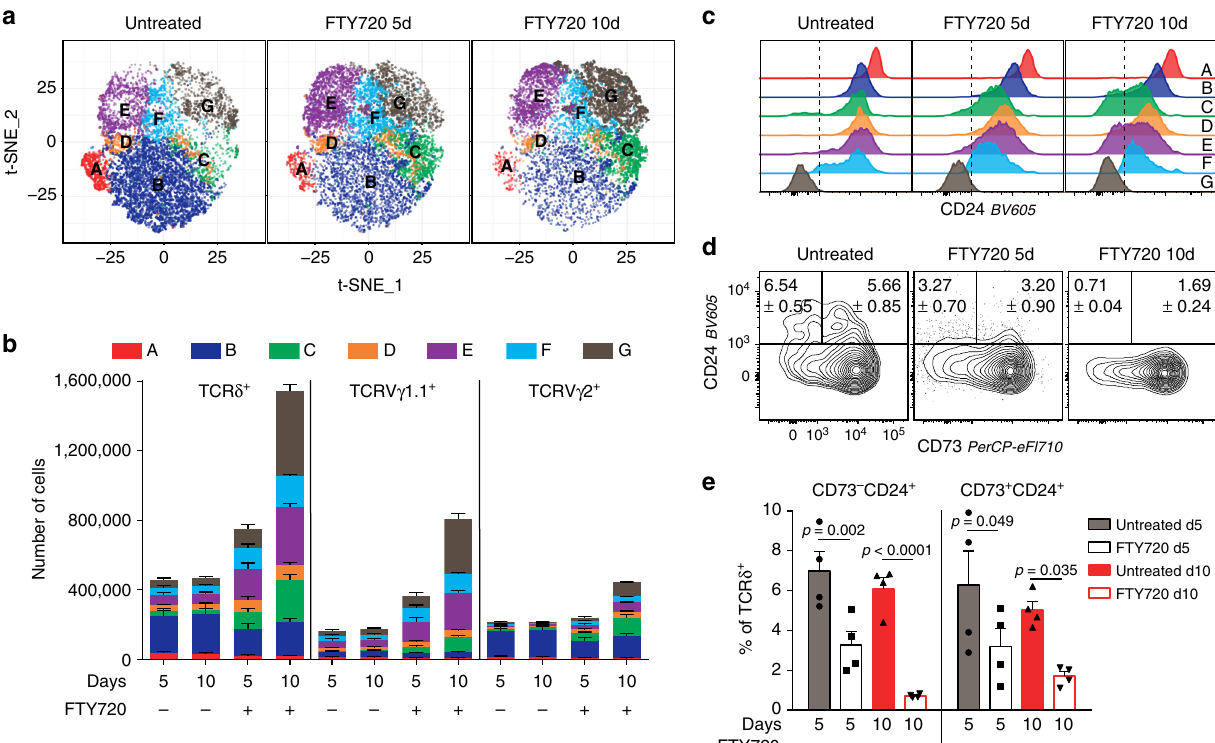
Fig. 5 γδ T cells emigrate from the thymus at the C, E and G stages a , b TCR δ + thymocyte distributions within population A to G after treatment with FTY720 for 5 (5d) or 10 days (10d) visualised using a t-SNE maps and b stacked bar plots of cell numbers within TCR δ + , V γ 1.1 + and V γ 2 + subsets. c Representative CD24 expression within A to G populations after treatment with FTY720 for 5 or 10 days. d , e Expression of CD24 within CD73 − and CD73 + TCR δ + cells from inguinal lymph nodes after FTY720 treatment for 5 and 10 days as d representative fl ow cytometry plots and e quantitative bar plots showing the percent of TCR δ + cells within each population. Data from two independent experiments for both 5- and 10-day treatments ( n = 4 mice per group per time point). Numbers within gates and bar plots depict the mean ± SEM. Statistical analyses were performed using the unpaired